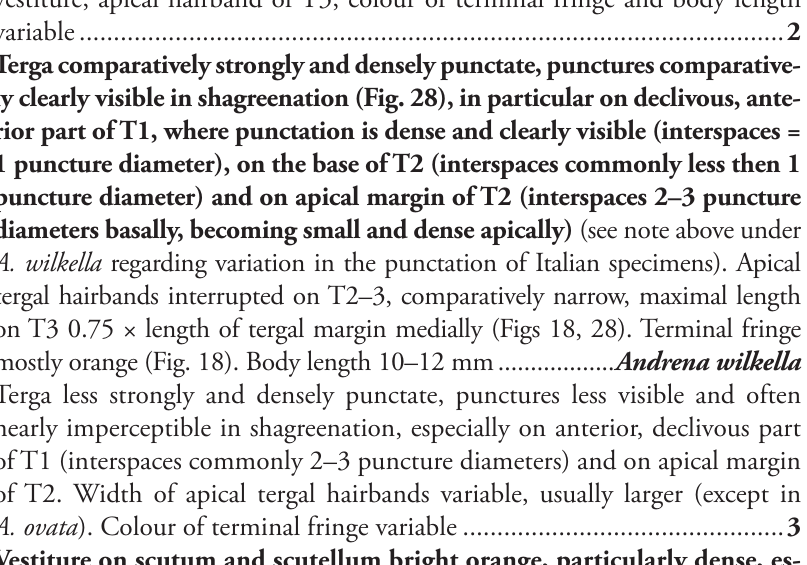
vestiture, apical hairband of T3, colour of terminal fringe and body length variable ....................................................................................................... 2 2 Terga comparatively strongly and densely punctate, punctures comparative- ly clearly visible in shagreenation (Fig. 28), in particular on declivous, ante- rior part of T1, where punctation is dense and clearly visible (interspaces = 1 puncture diameter), on the base of T2 (interspaces commonly less then 1 puncture diameter) and on apical margin of T2 (interspaces 2–3 puncture diameters basally, becoming small and dense apically) (see note above under A. wilkella regarding variation in the punctation of Italian specimens). Apical tergal hairbands interrupted on T2–3, comparatively narrow, maximal length on T3 0.75 × length of tergal margin medially (Figs 18, 28). Terminal fringe mostly orange (Fig. 18). Body length 10–12 mm .................. Andrena wilkella – Terga less strongly and densely punctate, punctures less visible and often nearly imperceptible in shagreenation, especially on anterior, declivous part of T1 (interspaces commonly 2–3 puncture diameters) and on apical margin of T2. Width of apical tergal hairbands variable, usually larger (except in A. ovata ). Colour of terminal fringe variable ............................................... 3 3 Vestiture on scutum and scutellum bright orange, particularly dense, es- pecially on lateral parts of scutellum. Terga with shallow, nearly indiscern- ible punctures (Fig. 26). Integument of hind tibia and tarsi orange. Terminal fringe orange. Tergal fringes of hairs long, but interrupted medially on T4 (Fig. 16). ............................................................................ Andrena russula – Vestiture on scutum yellowish brown, brown-orange or grey, less dense. Ter- gal punctation, colour of integument of hind tibia and tarsi, colour of termi- nal fringe and tergal fringes variable ............................................................ 4 4 Integument of T1–T4 partly red (Figs 12, 22) , rarely brown, but then mar- gin or parts of tergal discs reddish brown. T1 nearly impunctate (Fig. 22). Disc of T2 very sparsely (interspaces over 3 puncture diameters) and faintly punctate, punctures hardly discernible (Fig. 22). Apical hairbands of T2–T4 very narrow, white (Fig. 22). Scutellum weakly shagreened even centrally. Body length 8–9 mm. ................................................ Andrena croceiventris – Integument of T1–T4 dark brown. Punctation of terga variable, but if disc of T1 nearly impunctate and disc of T2 very sparsely punctate, then body size > 10 mm. Width of tergal fringes variable. Scutellum usually partly shiny. Body length variable ............................................................................................ 5 5 Terga strongly shagreened, punctures little visible, disc of T1 and margins of T2–T4 appearing impunctate (Fig. 25). Scutal punctures comparatively shallow, little visible (Fig. 63) . Clypeus shagreened, punctation sparse and shal- low (Fig. 64). Tergal fasciae narrow, snow white, interrupted on T3 (Figs 15, 25). Scutal vestiture predominantly greyish white in fresh specimens (Fig. 62). Termi- nal fringe brownish grey (Fig. 15). Body length 10–12 mm ........ Andrena ovata – Terga more shiny and distinctly punctate. Scutal punctures deep and clearly visible. Sculpture of clypeus variable. Colour of tergal fasciae variable, often brownish in fresh specimens, wider, interrupted or not on T3. Scutal